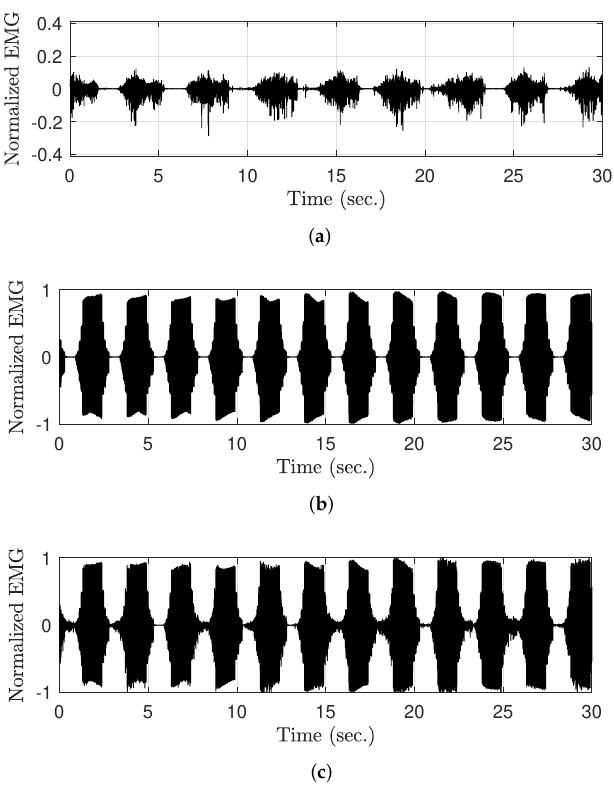
Figure 6. Semi-simulated raw EMG data during FES for the verification of the DESTD method: ( a ) Raw EMG data with volitional effort, ( b ) raw EMG data without volitional effort during FES, and ( c ) semi-simulated raw EMG data with volitional effort during